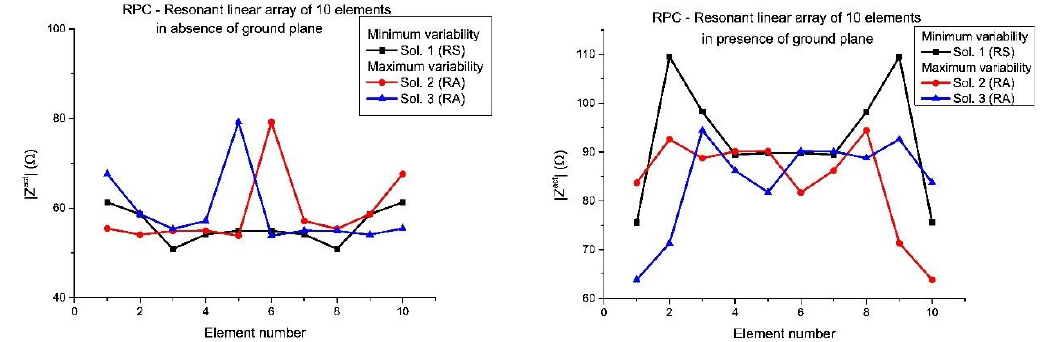
Figure 10. Detailed view of the active impedances which present the maximum and the minimum variability from the set of solutions for the RPC, in the case of the resonant linear array of 10 elements: in absence of ground plane ( left ) and in presence of ground plane ( right ).